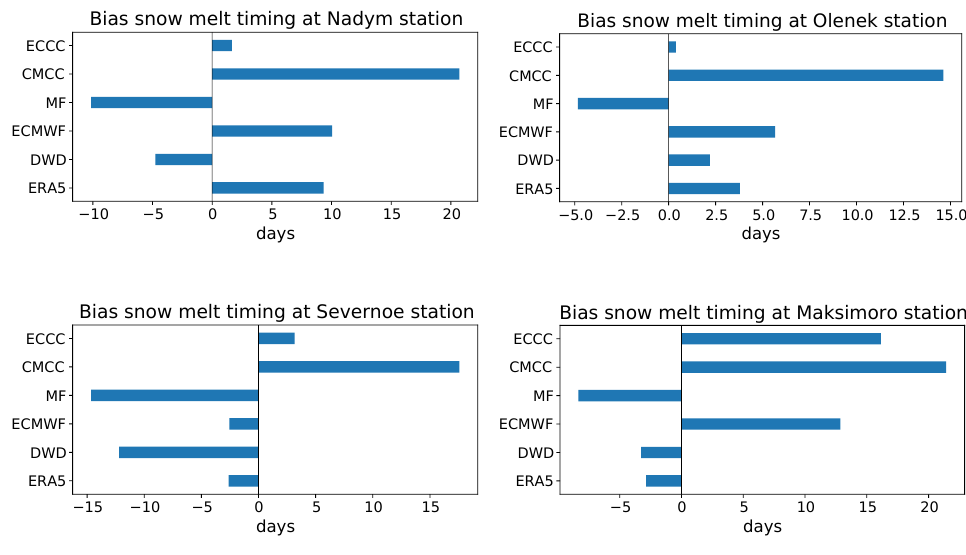
Figure 7. Days between the maximum and one-third of the snow depth at the grid-point closest to the station.